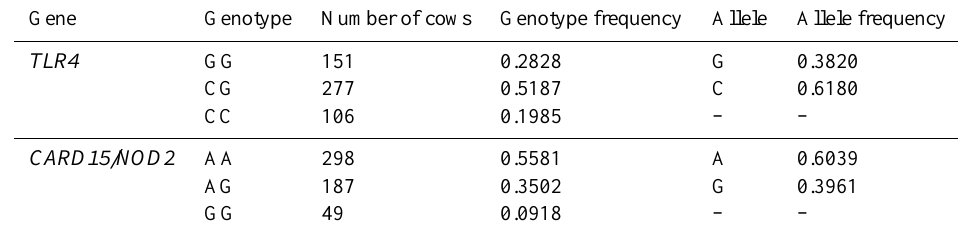
Table 2. Frequency of TLR4 and CARD15/NOD2 genotypes and alleles. Gene